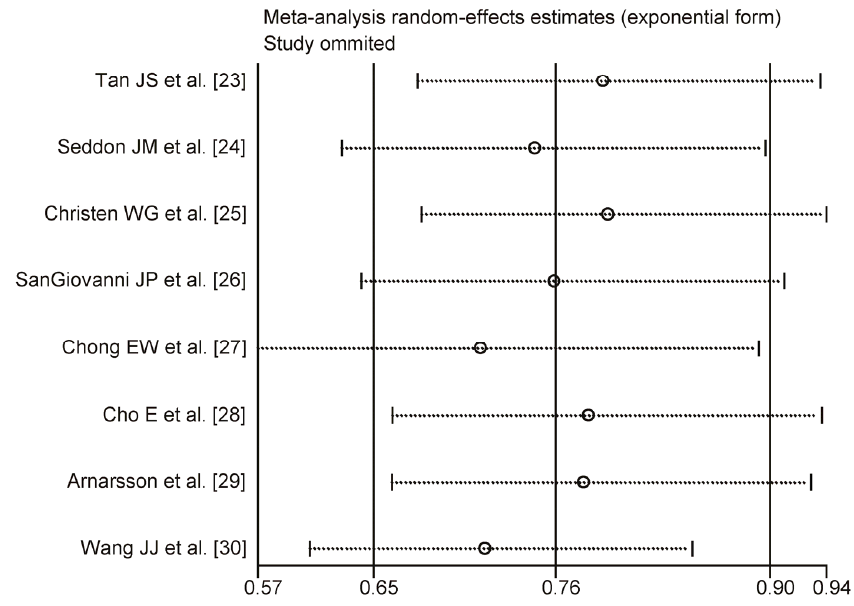
Figure 3. One-way sensitivity analysis for the association between fish intake and AMD risk. Figure 3. One ‐ way sensitivity analysis for the association between fish intake and AMD risk. There There were no studies influencing the result of fish consumption on AMD. were no studies influencing the result of fish consumption on AMD.